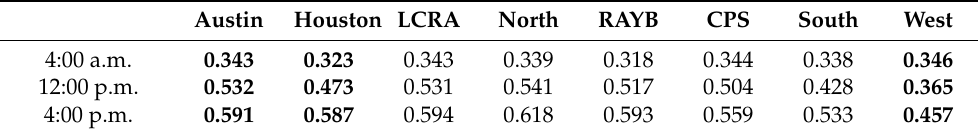
Table 2. Correlations between the actual price series and estimated factor series for all zones.